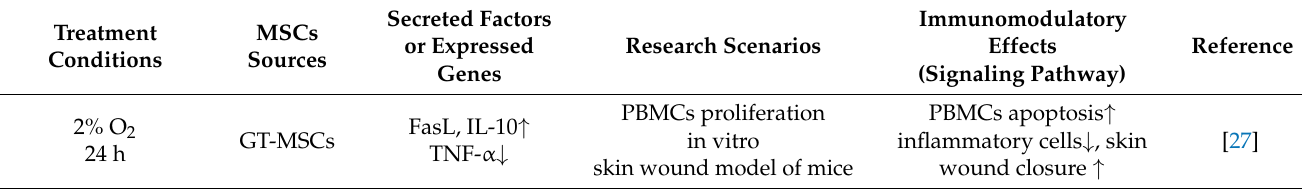
Table 1. Hypoxia pretreatment of